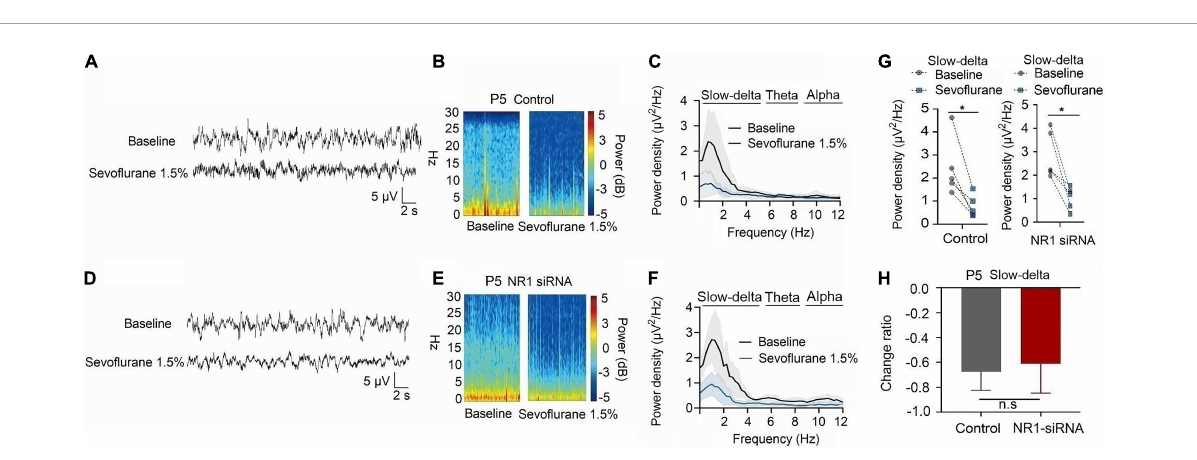
FIGURE6 Knockdown of NR1 did not change the effect of slow-delta oscillations in P5 rats under sevoflurane anesthesia. (A,B,D,E) EEG and it’s power spectrogram of P5 rats under sevoflurane in the control group and NR1-siRNA group. (C,F) EEG power spectral density of P5 rats under sevoflurane in the control group and NR1-siRNA group ( n = 5). EEG power spectral density. (G) The change of power density of slow-delta oscillations of P5 rats under sevoflurane in the control group and NR1-siRNA group ( n = 5). (H) The change ratio of the power density of slow-delta oscillations of P5 rats under sevoflurane ( n = 5). Data are presented as mean ± SD. n.s., not significant; * P < 0.05 by paired t -test (G) and unpaired t -test (H)